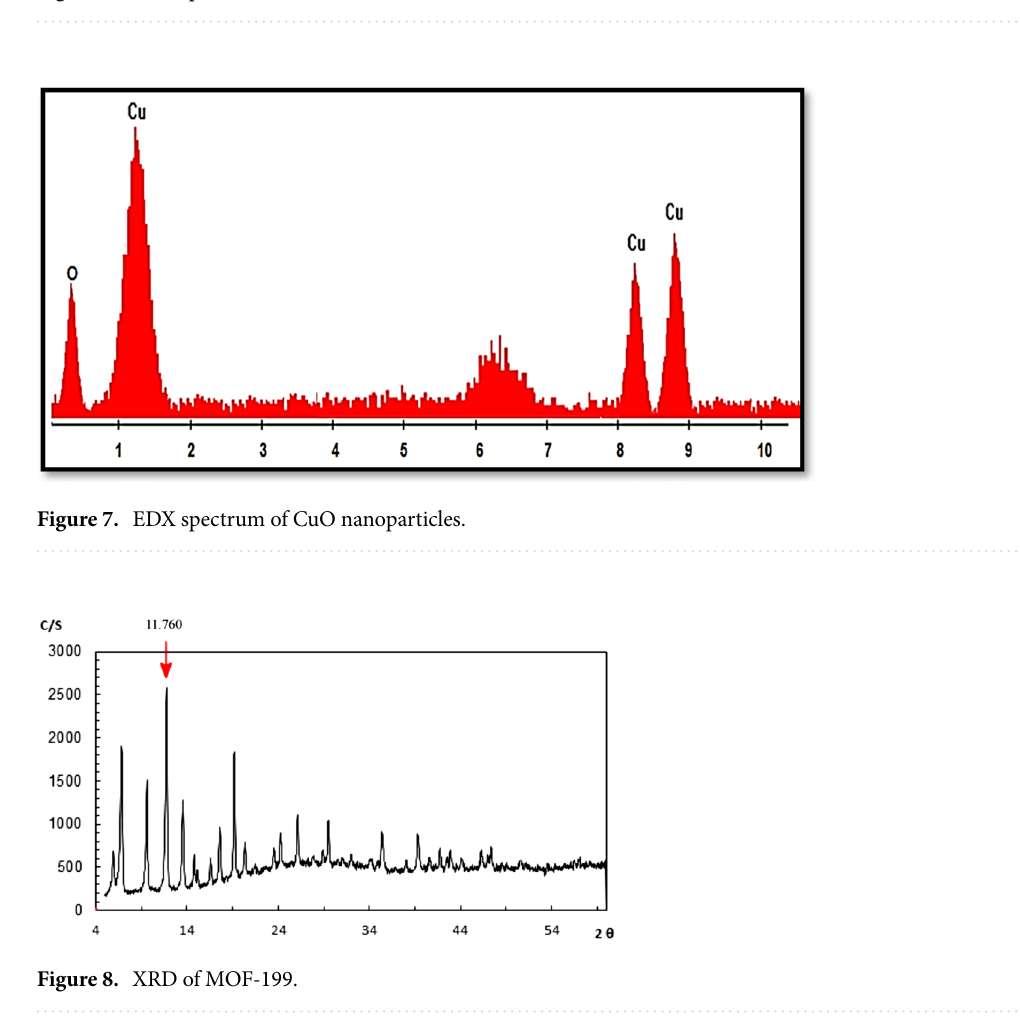
Figure 6. EDX spectrum of MOF-199.